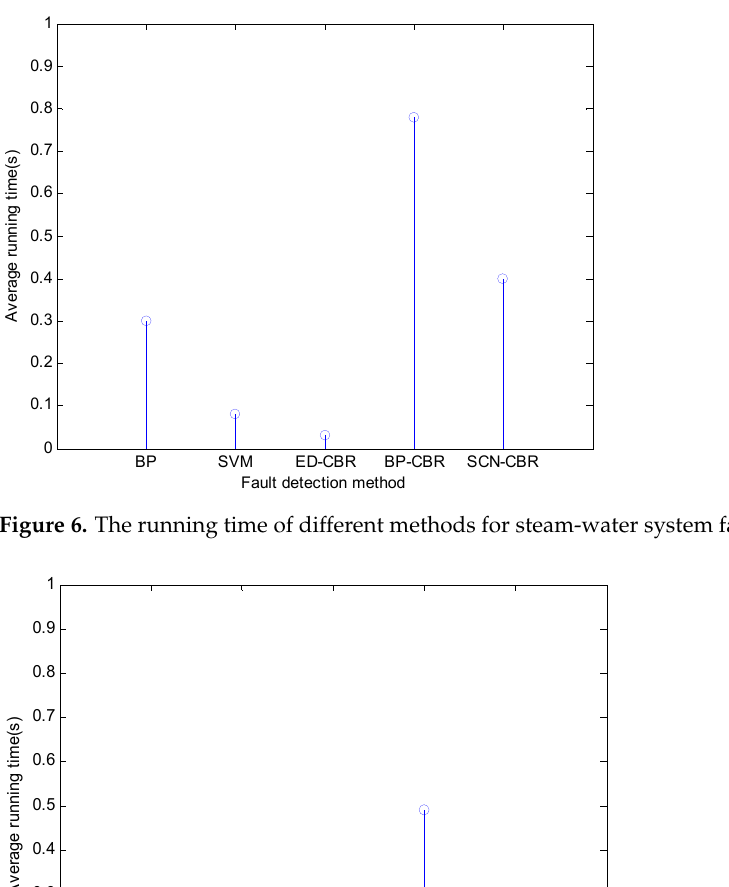
Figure 5. Multi-fault detection accuracy (%).